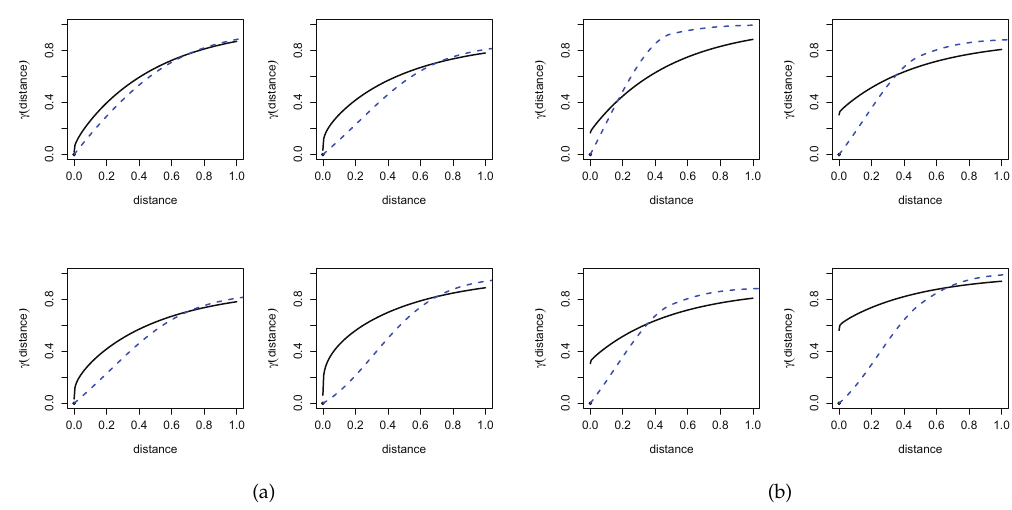
Figure 2. ( a ) Plots of γ ii (cid:48) under a correct characterization of γ 1 and γ 2 (Exp-Mat, black solid line) and a misspecified combination (Exp-Gau, blue dashed line). ( b ) Plots of γ ii (cid:48) under a correct characterization of γ 1 and γ 2 (Exp-Mat, black solid line) and a misspecified combination (Sph-Gau, blue dashed line).